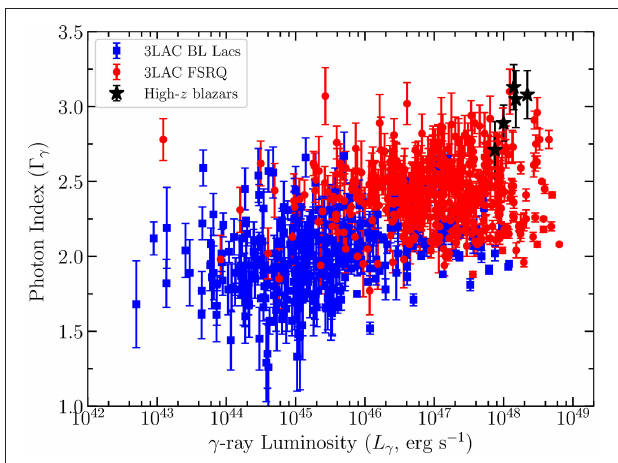
FIGURE 1 | Photon index vs. γ -ray luminosity plane for 3LAC and high-redshift blazars at z > 3.1 detected in γ rays. Adapted from Ackermann et al. (2017).